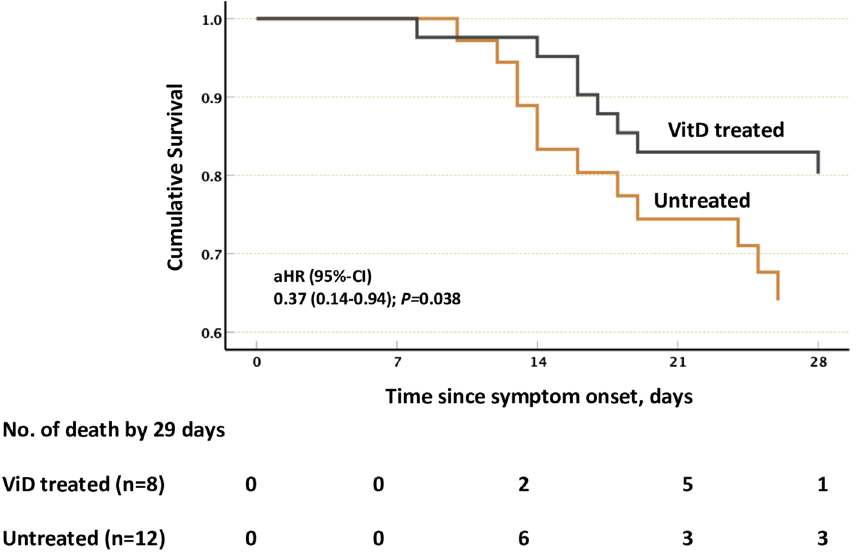
Figure 4. Lower 29-day all-cause mortality of VitD treated COVID-19 patients. The Kaplan–Meier curve of VitD treated (n = 43, 8 death events) and untreated COVID-19 patients (n = 37, 12 death events). The Cox proportional hazards regression model was adjusted for patient’s demographics factors (age, gender, and body mass index), comorbidities (diabetes mellitus), and COVID-19 related severity serum marker (D-dimer and C-reactive